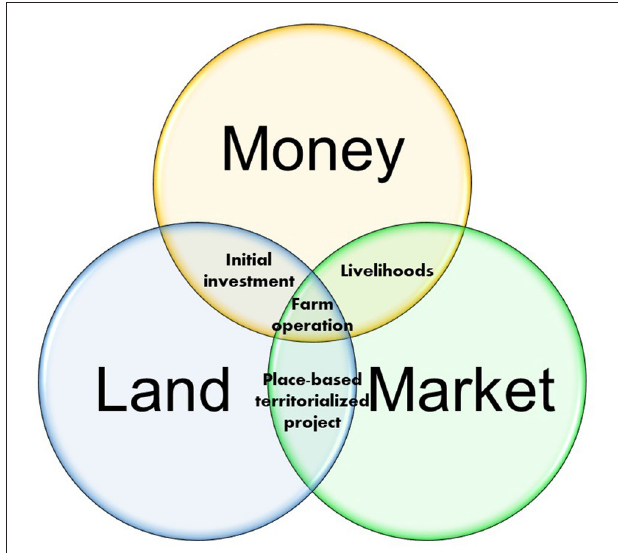
FIGURE 2 | The money-land-market nexus locking-in the agricultural